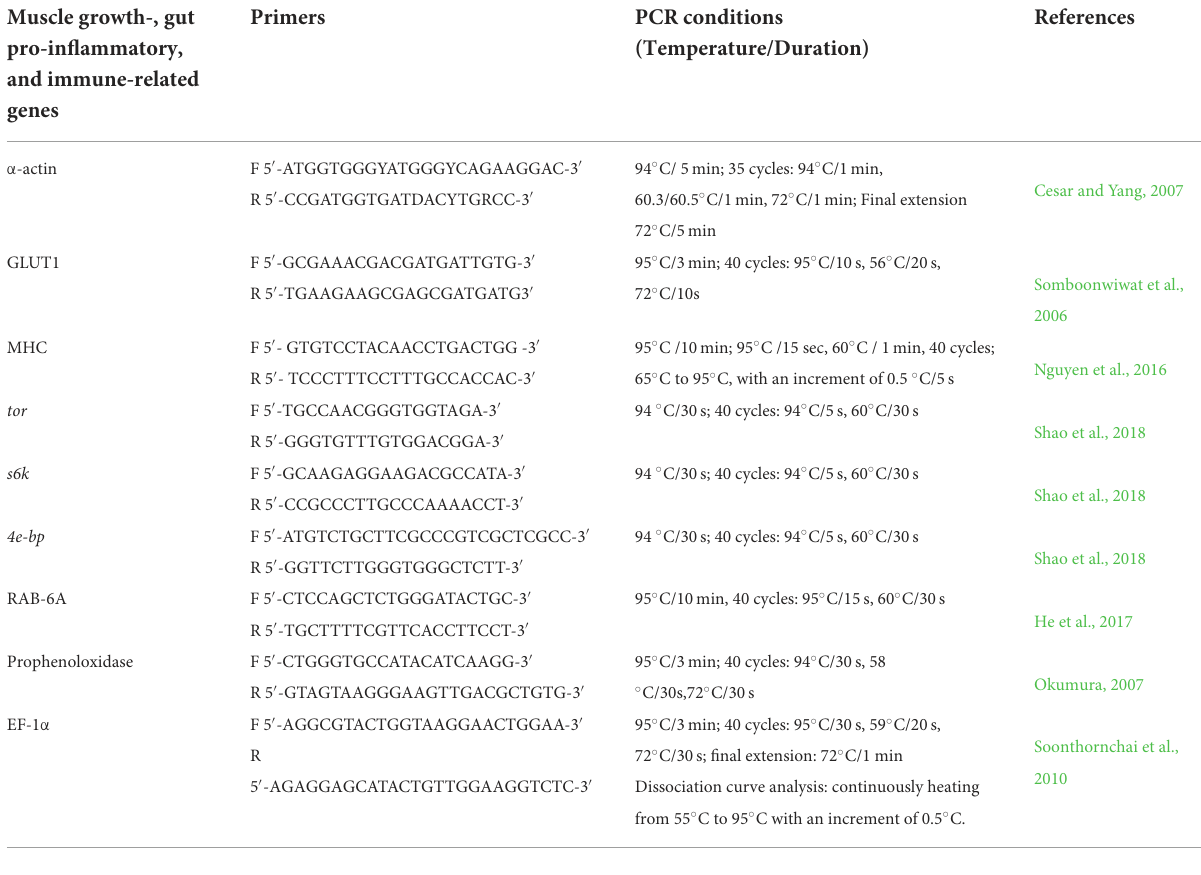
TABLE 2 Primers and conditions utilized in real-time reverse transcription polymerase chain reaction. Muscle growth-, gut Primers PCR conditions pro-inflammatory, and immune-related